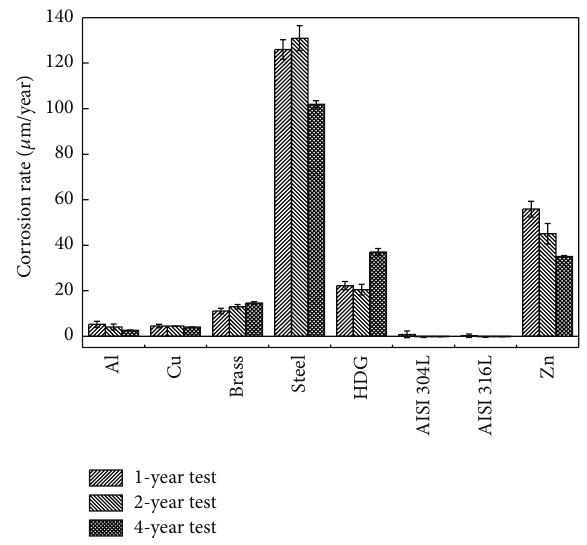
Figure 9: Comparison of corrosion rates in immersion tests for 1-, 2-, and 4-year